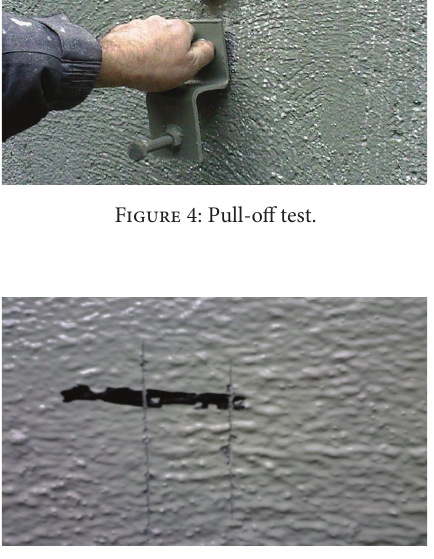
Figure 5: Cut test: measuring of the film